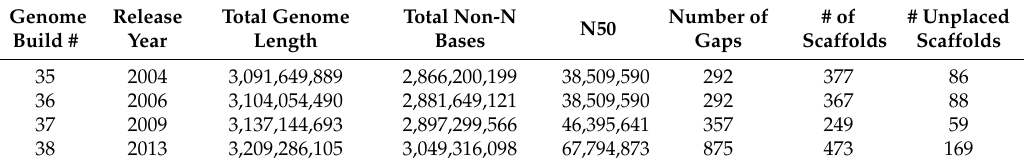
Table 1. Basic statistics for the recent releases of human reference genome